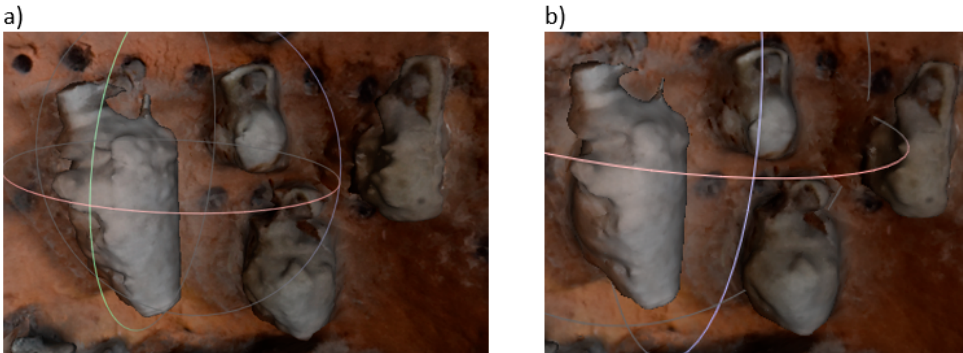
Figure 16. 3D model with the texture of the dishes in the furnace: ( a ) original version, ( b ) after smoothing the surface.